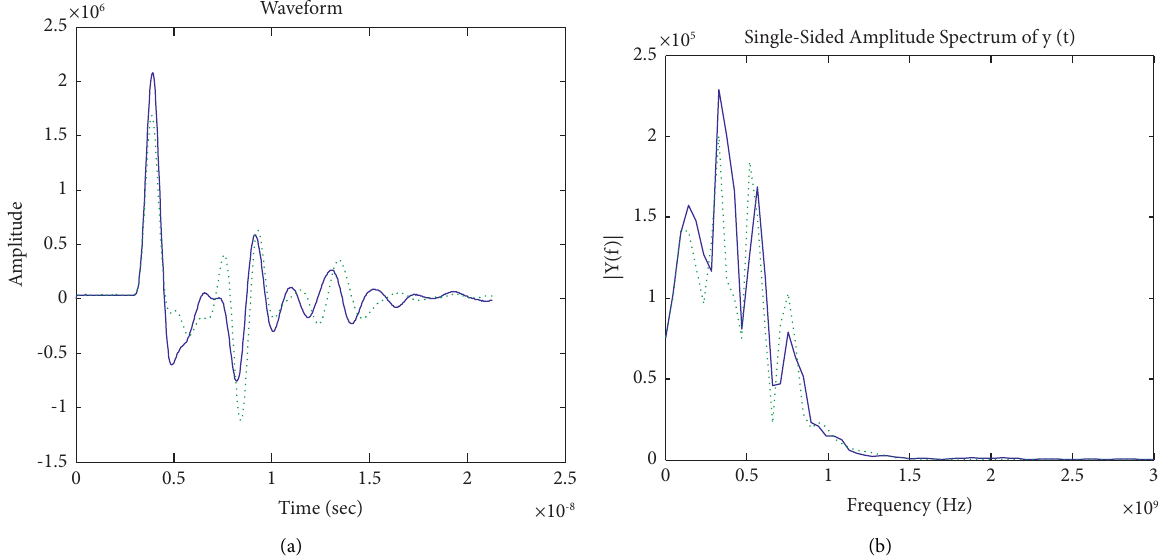
Figure 6: (a) GPR signals of dry ballast vs wet ballast (solid line: dry; dotted line: wet). (b) FFTof GPR signals of dry ballast vs wet ballast (solid line: dry; dotted line: wet).